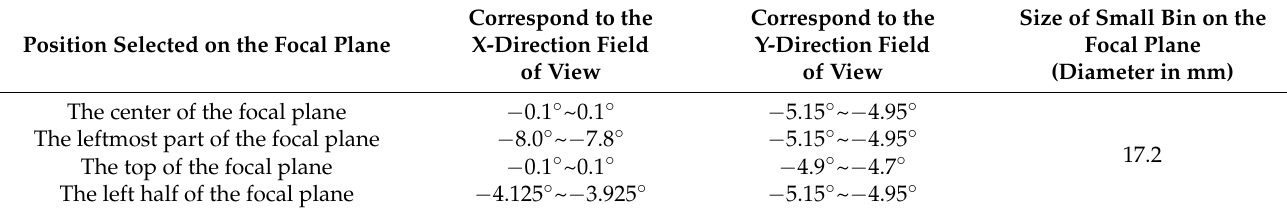
Table 6. Settings of light sources in different field of view